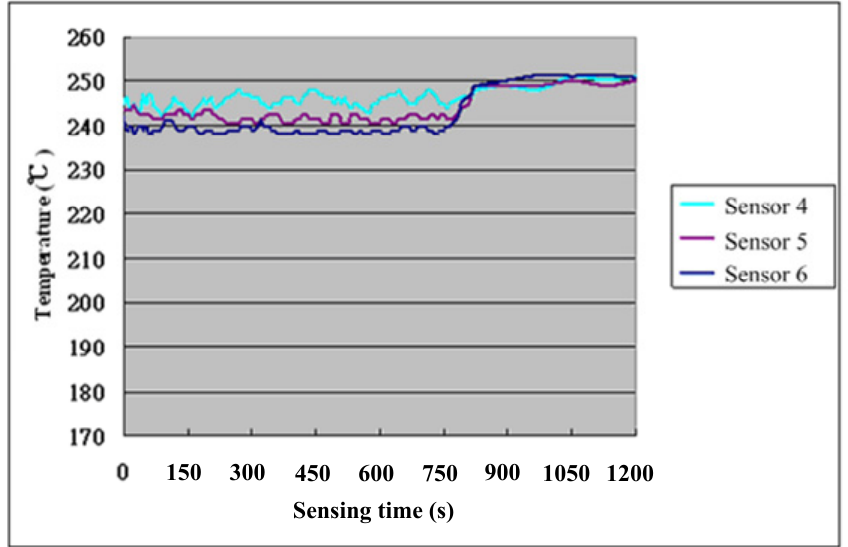
Figure 9. Temperature distribution of micro sensors 4 ~ 6 insider the reformer.